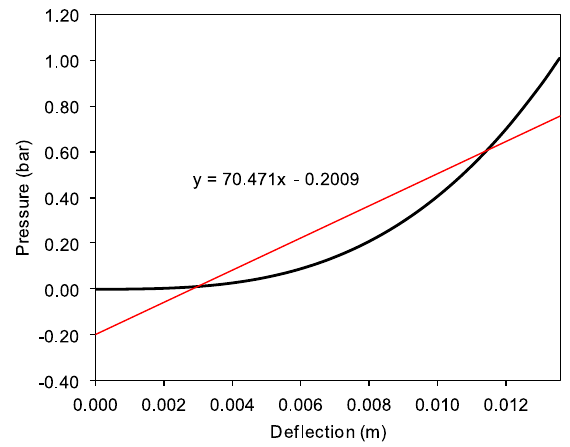
Figure 3. Load-deflectioncurveforquasi-staticenergyanalysisshow- ing linearized function over range of data.